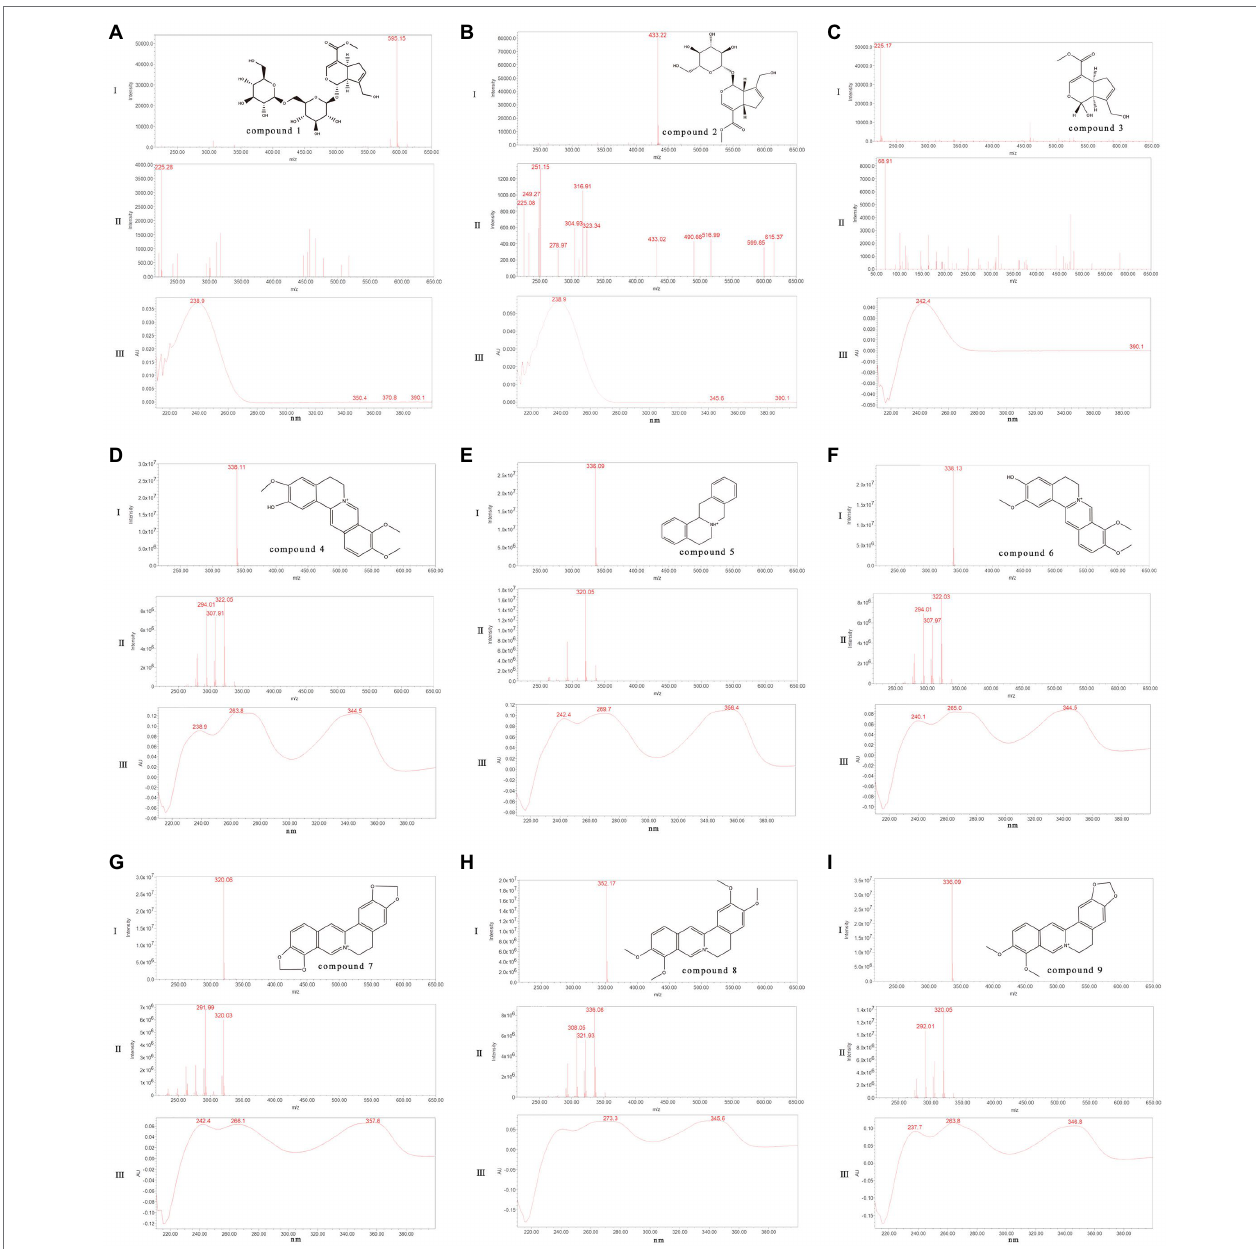
FIGURE 2 | Identification of the main chemical components in the fermentation process of LZF [I: UPLC-ESI-MS Spectrum (10 ev); II: UPLC-ESI-MS Spectrum (50 ev); III: UPLC-PDA Spectrum (210–400 nm)]. (A) Compound 1: Genipin-1- β -D-gentiobioside; (B) Compound 2: Geniposide; (C) Compound 3: Genipin; (D) Compound 4: Columbamine; (E) Compound 5: Epiberberine; (F) Compound 6: Jatrorrhizine; (G) Compound 7: Coptisine; (H) Compound 8: Palmatine; and (I) Compound 9: